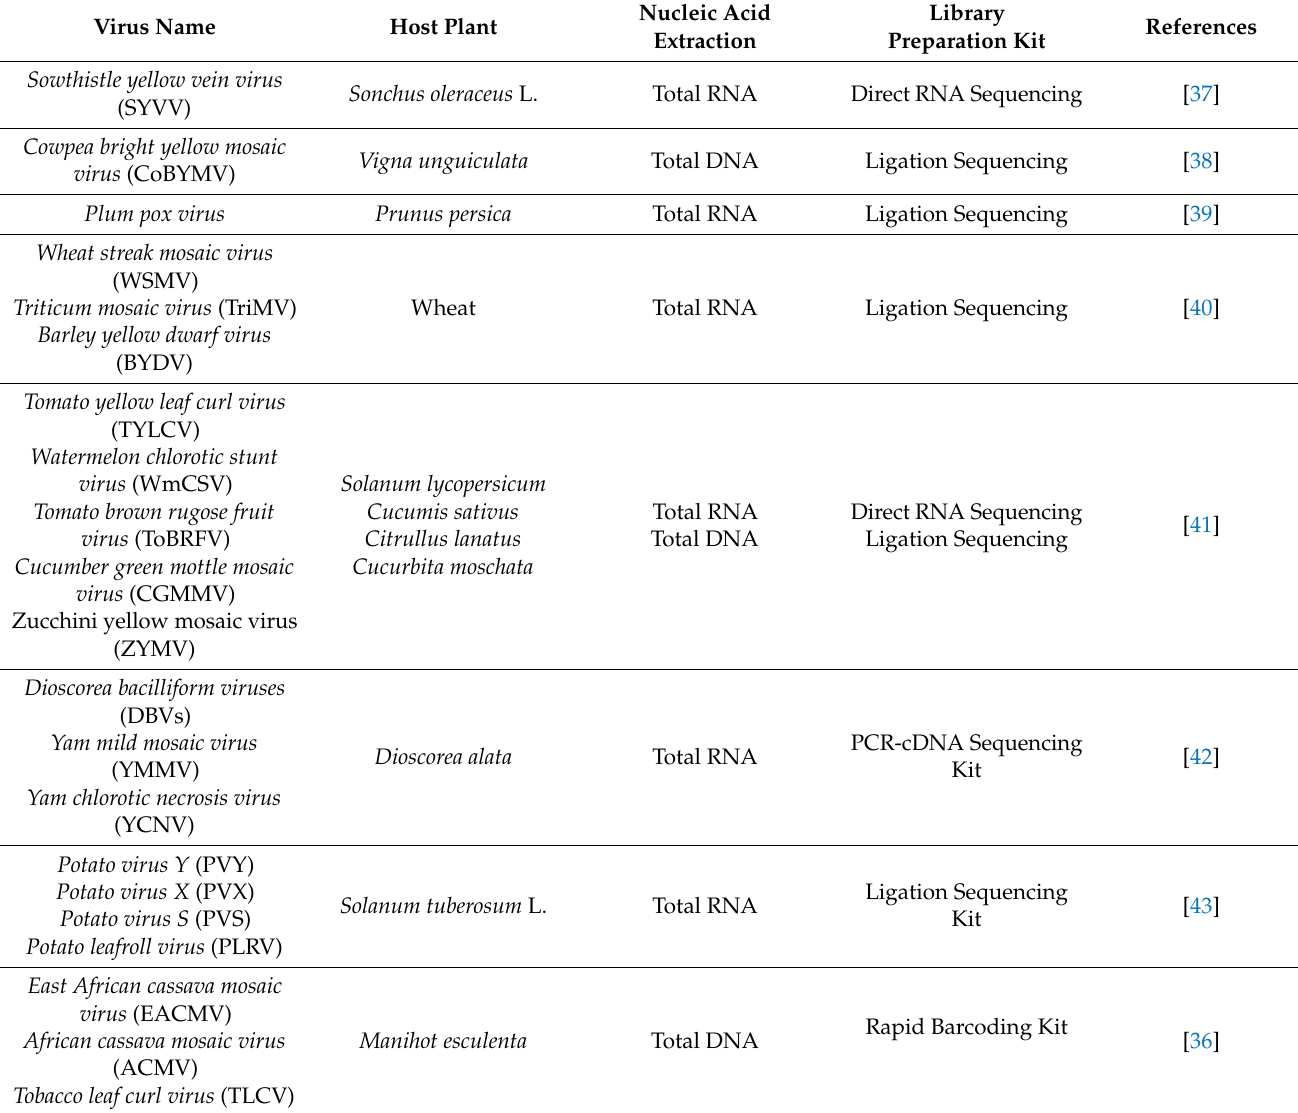
Table 2. List of plant viruses detected using nanopore sequencing